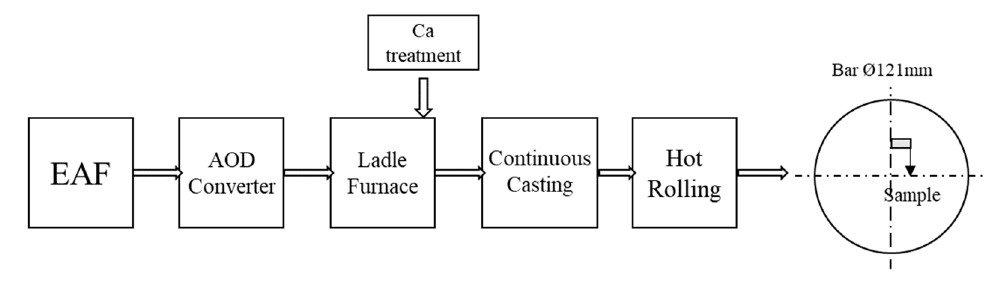
Figure 1. Schematic illustration of the production process of 316L stainless steel, from the melting of scrap and alloys in an Electric Arc Furnace (EAF) to hot rolling.